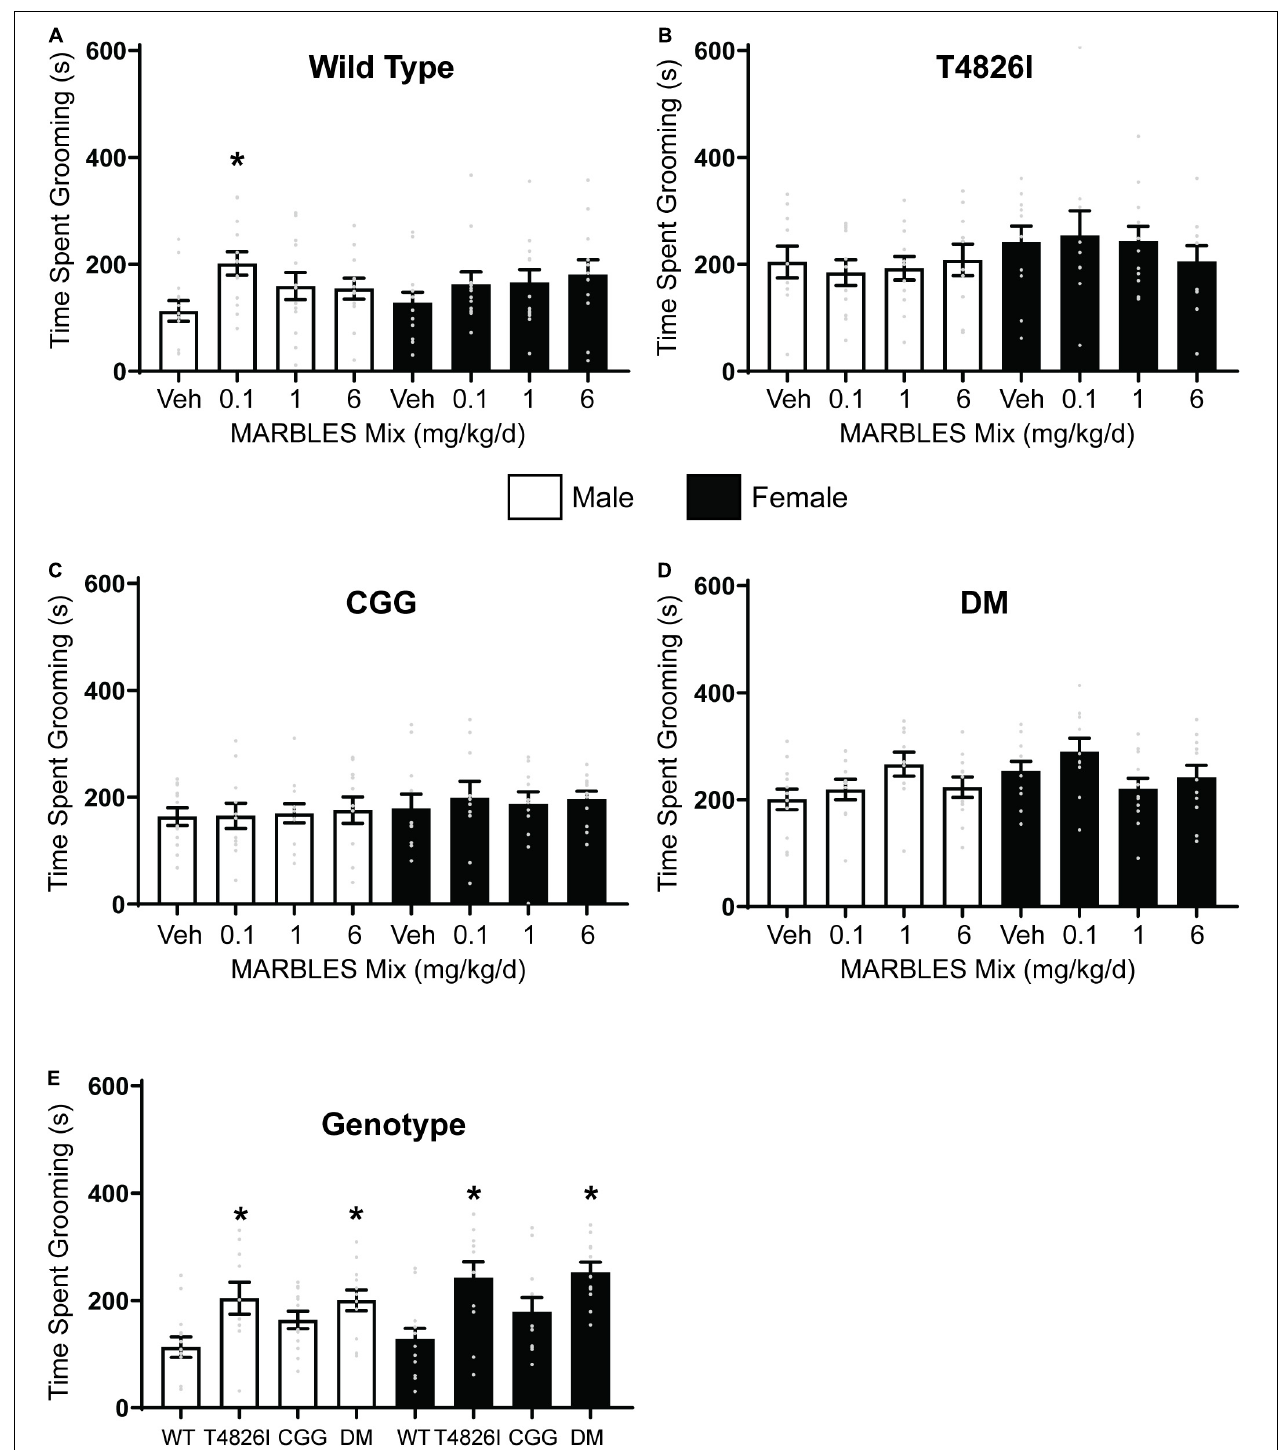
FIGURE 2 | Developmental PCB exposure or expression of expression of a gain-of-function RyR mutation (T4826I) increased repetitive behavior in P26-28 mice. Repetitive behavior was assessed in one male and one female per litter per experimental group by quantifying the time spent grooming in (A) WT, (B) T4826I, (C) CGG, or (D) DM mice during a 10-min period. (E) Time spent grooming in vehicle control mice of each genotype. Cumulative time spent grooming is presented as mean ± SEM ( n = 10–13). * Indicates significantly different from sex-matched (A–D) vehicle control or (E) sex-matched WT at p < 0.05 as determined using a one-way ANOVA or Kruskal Wallis test with post hoc Holm-Sidak’s multiple comparisons test or Dunn’s test, respectively.